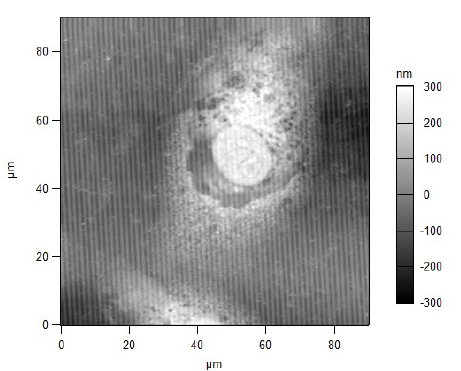
Figure 4. Vero cell at 24 h p.i .; AFM scan of the diffraction grating.